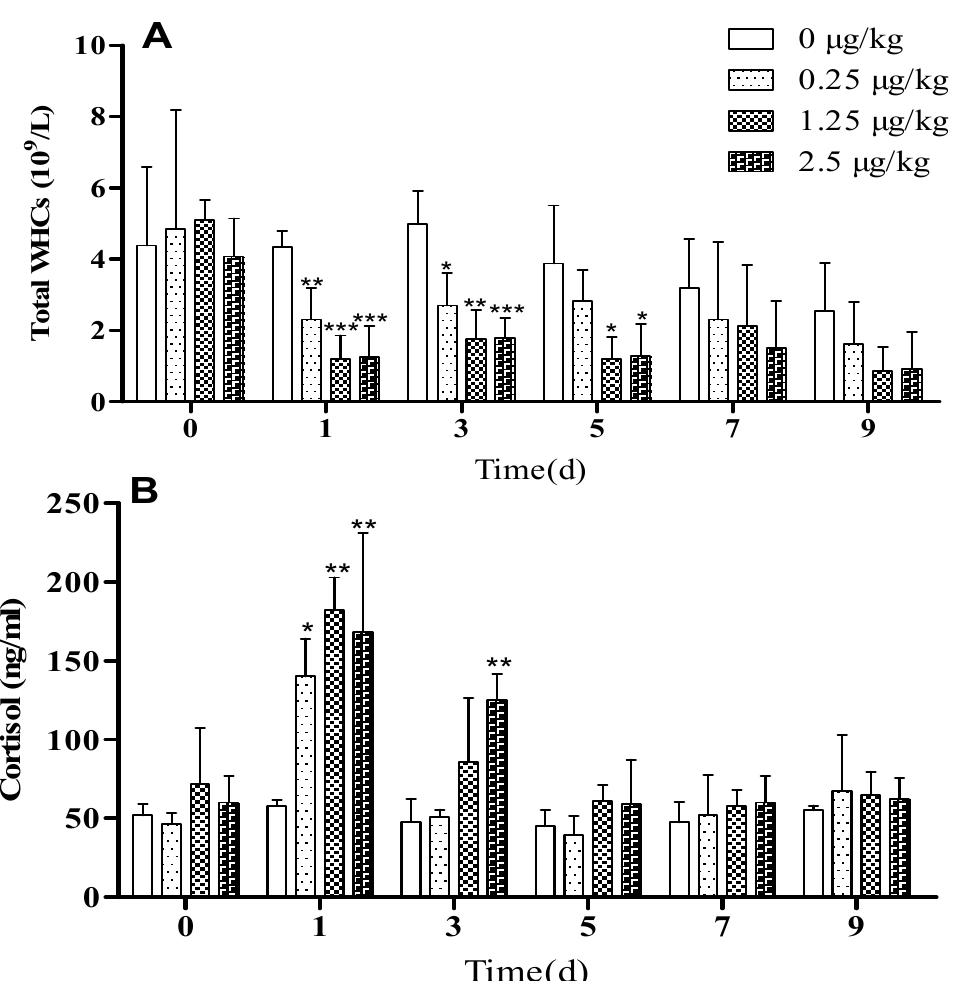
Figure 2. E ff ect of 0.25, 1.25, and 2.5 µ g / kg LPS on ( A ) white blood cells (WBCs) and ( B ) plasma cortisol concentration in lambs. Values are expressed as means ± SD. * p < 0.05, ** p < 0.01, and *** p < 0.001, compared with the control group.